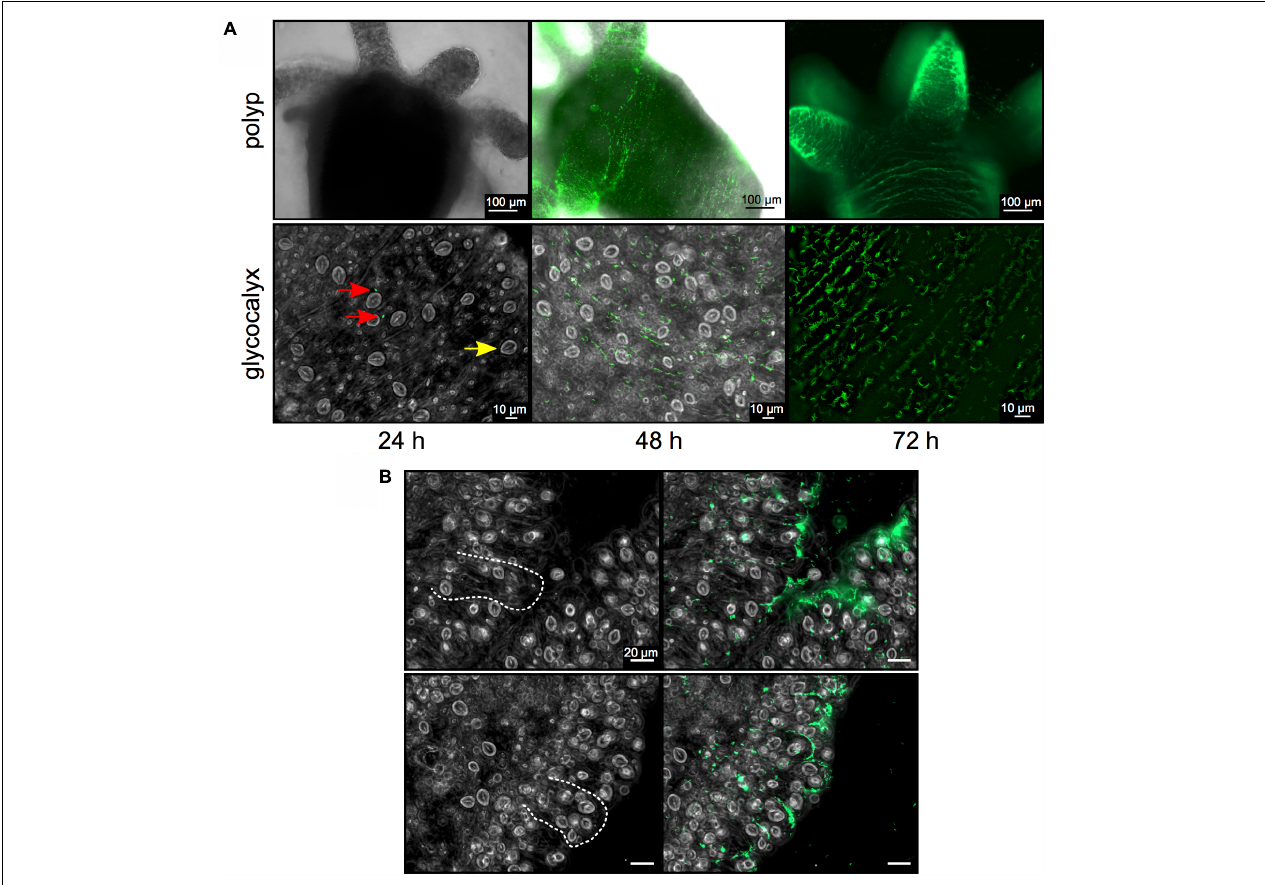
FIGURE 2 | Curvibacter population size dynamics on Hydra . (A) Twenty-four hours post-infection, single Curvibacter cells (red arrows) are attached to the polyp (yellow arrow indicates a host nematocyst). Proliferation of Curvibacter leads to a dense layer of cells after 48 and 72 h. (B) Bright field micrographs of Hydra epithelium. Dashed lines indicate the shape of the epithelial battery cells filled with nematocyst in the tentacles of Hydra (left). Curvibacter carrying pRL153-GFP colonizing the Hydra epithelium along the shape of the epithelial muscle cells